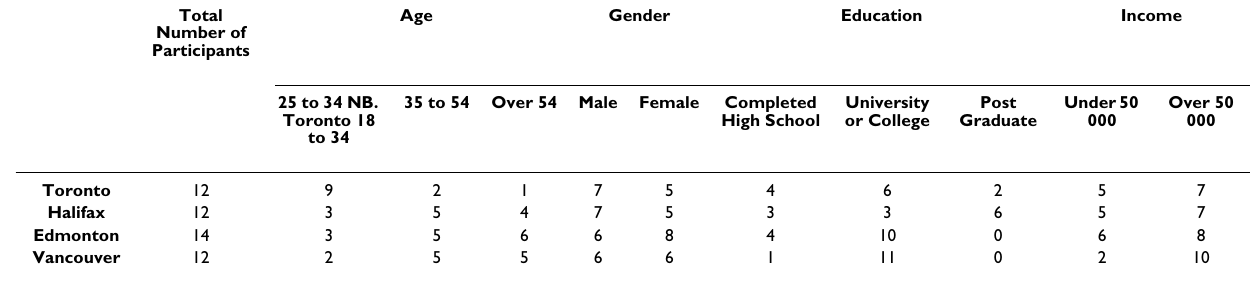
Table 2: Summary of Consumers'